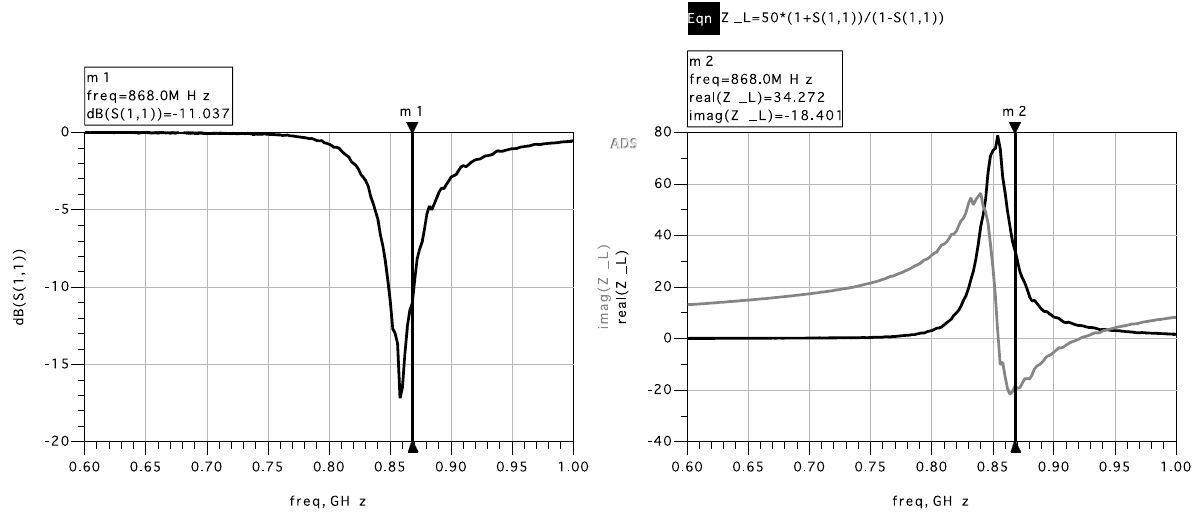
Figure 6. ADS simulation of reflection coefficient S11.